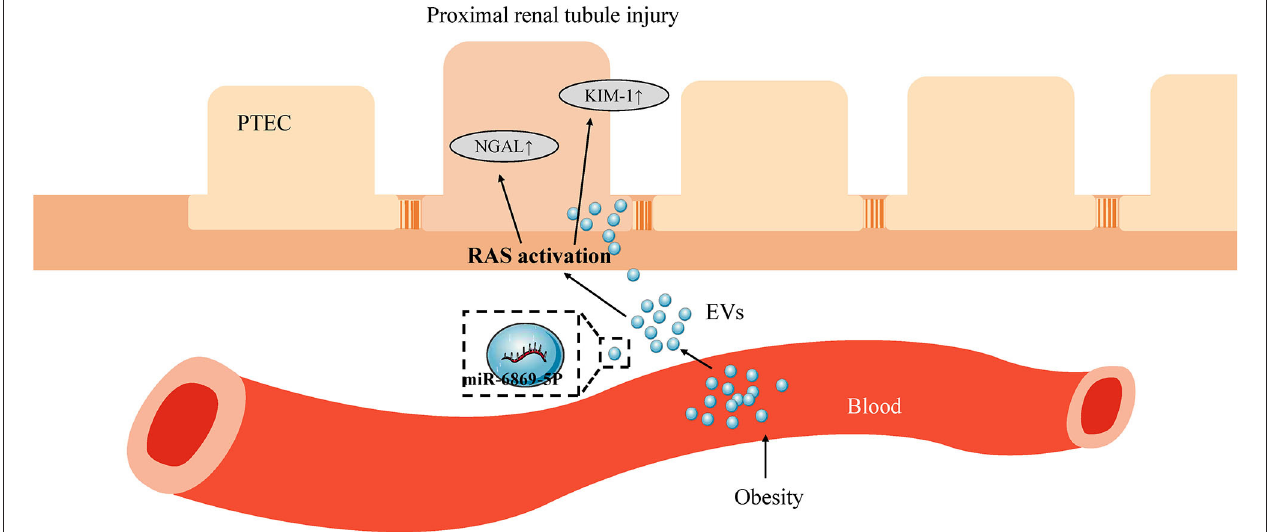
FIGURE 7 | Scheme depicting the role of plasma EV miR-6869-5p and RAS in obesity-related renal tubule injury. In obesity, plasma EVs transport miR-6869-5p into PTECs. miR-6869-5p activates RAS and promotes the expression of KIM-1 and NGAL, markers of renal tubule injury. EVs, extracellular vesicles; PTECs, Proximal tubular epithelial cells; RAS, renin-angiotensin system; KIM-1, kidney injury molecule-1; NGAL, neutrophil gelatinase-associated